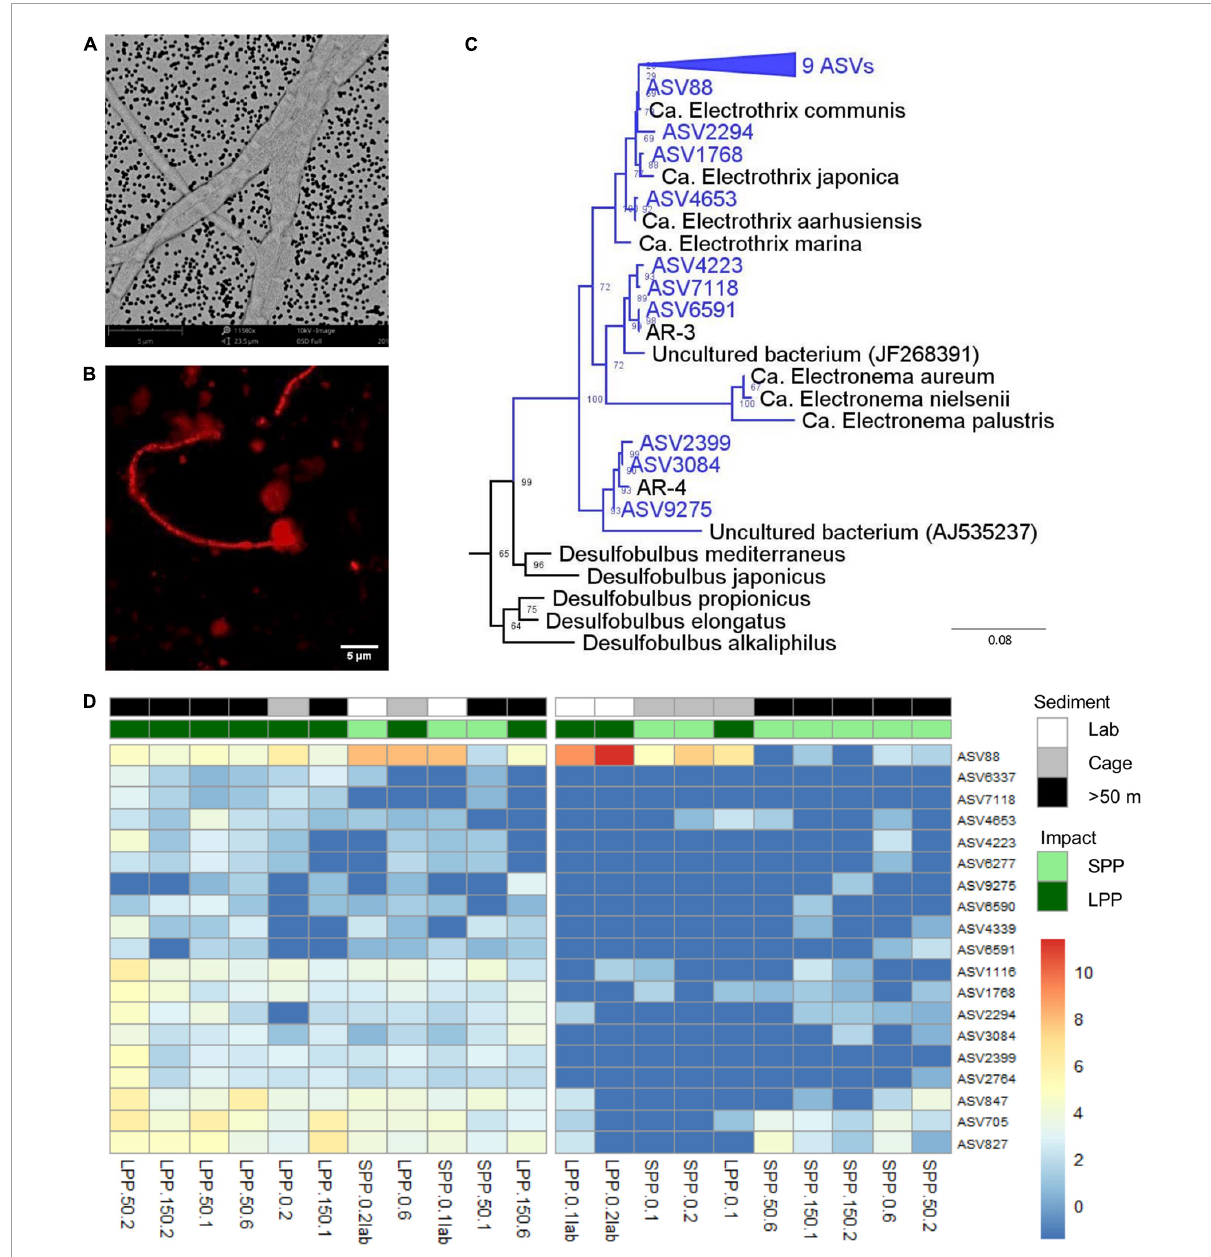
FIGURE5 Evidence of the presence of cable bacteria in fish farm sediment. (A) SEM image of picked cable bacteria filaments from lab incubated sediments. (B) Cable bacteria filament from incubated sediments stained with DSB706 probe via FISH technique. (C) Phylogenetic (consensus) tree of 19 ASVs (blue) with > 94.5% sequence similarity to known cable bacteria genera ( Ca. Electrothrix, Ca. Electronema, AR-3, and AR-4), from both field and lab incubated fish farm sediments. Bootstrap values are stated at the nodes, 4 references sequences from the Desulfobulbia class are included and E. coli was used as root. (D) Relative abundance of 19 ASVs identified as Ca . Electrothrix from all fish farm sediments: Lab incubated sediment (white), field sediment under the Cages (gray), field sediment collected > 50 m away from cages (black). Abundances were normalized with variance stabilization transformation (blue to red scale bar). Sample code indicate production period: LPP, long (dark green); SPP, short (light green); distance from cage: 0 = cage, 50 = 50 m, 150 = 150 m; and sediment layer: 1 = 0–0.5 cm, 2 = 0.5–1.0 cm, 6 = 3.0–5.0 cm. Lab incubations are additionally labeled as lab